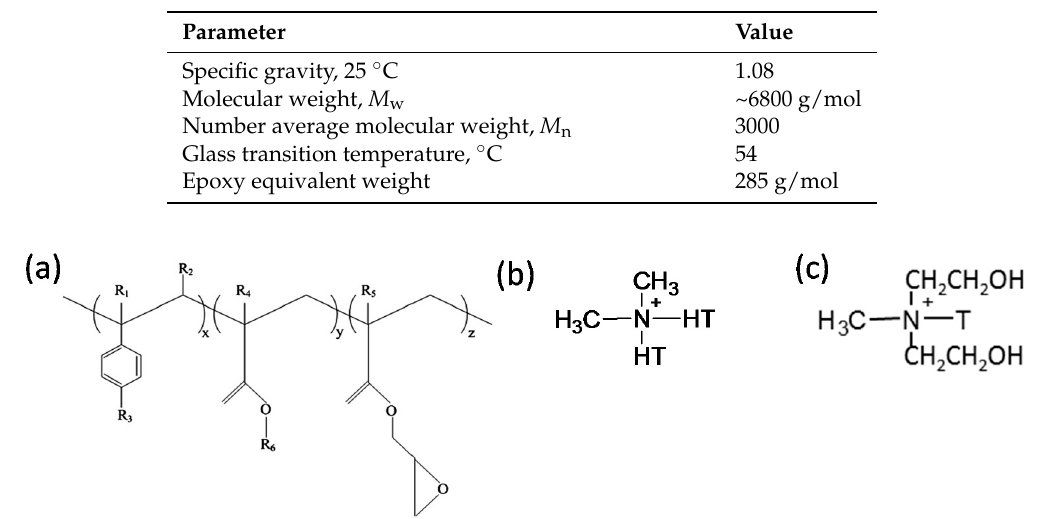
Table 1. Typical physical characteristics of Joncryl ® ADR 4368 CS.